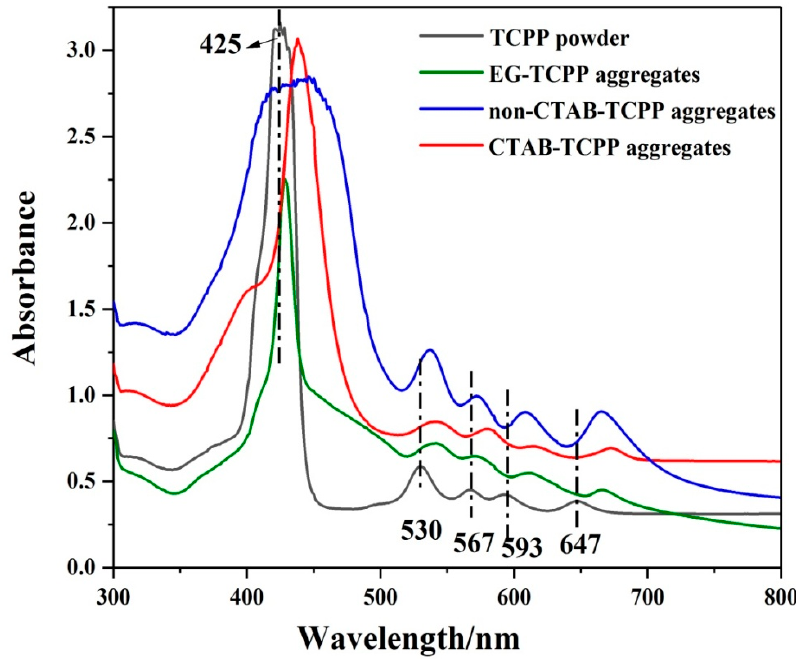
Figure 2. UV − vis absorption spectra of different TCPP aggregates and monomer.